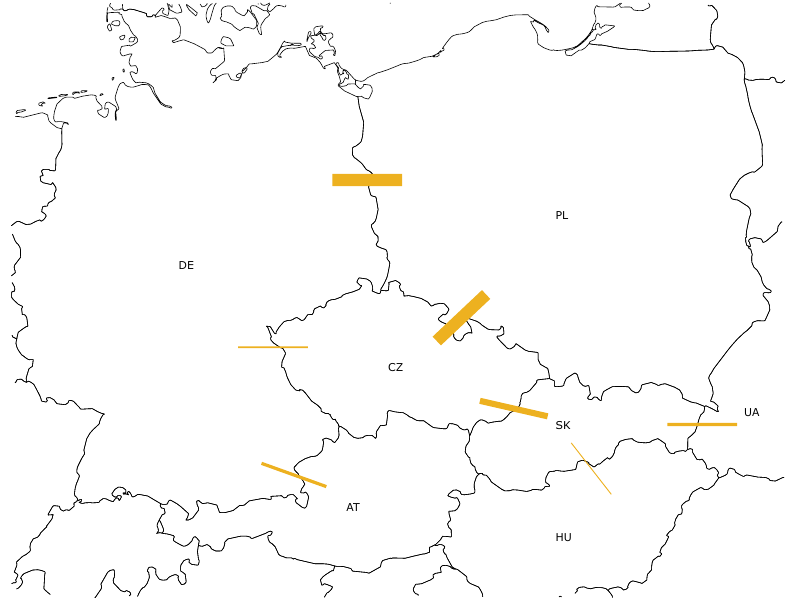
Figure 1. Congestions on critical branch–critical outages (CBCOs) per borders. The width of the orange line is proportional to the product of average congestion severity (when the congestion is non-zero) and the total number of congested CBCOs per border across 24 grid scenarios. Source: own calculations.